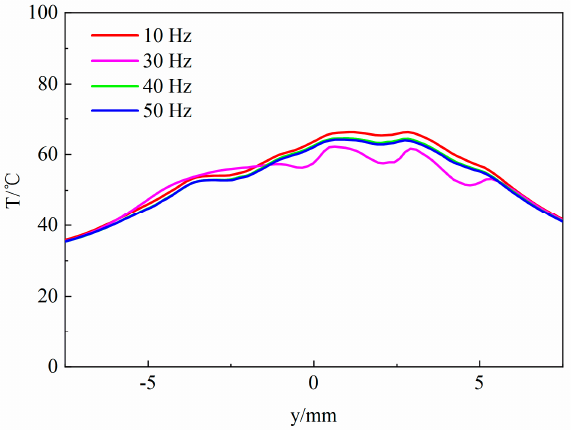
Figure 21. The change of the periodic average temperature of the wall along the y direction along the channel with the diaphragm frequency ( x = 28.5 mm).